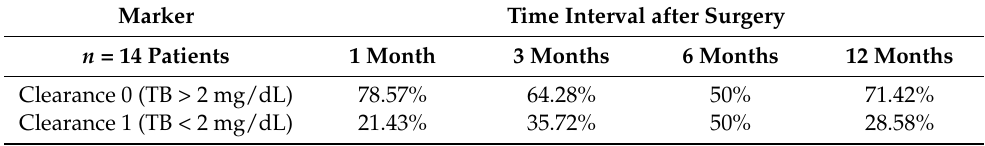
Table 2. Clearance rate after surgery (TB > 2 mg/dL). Marker Time Interval after Surgery n = 14 Patients